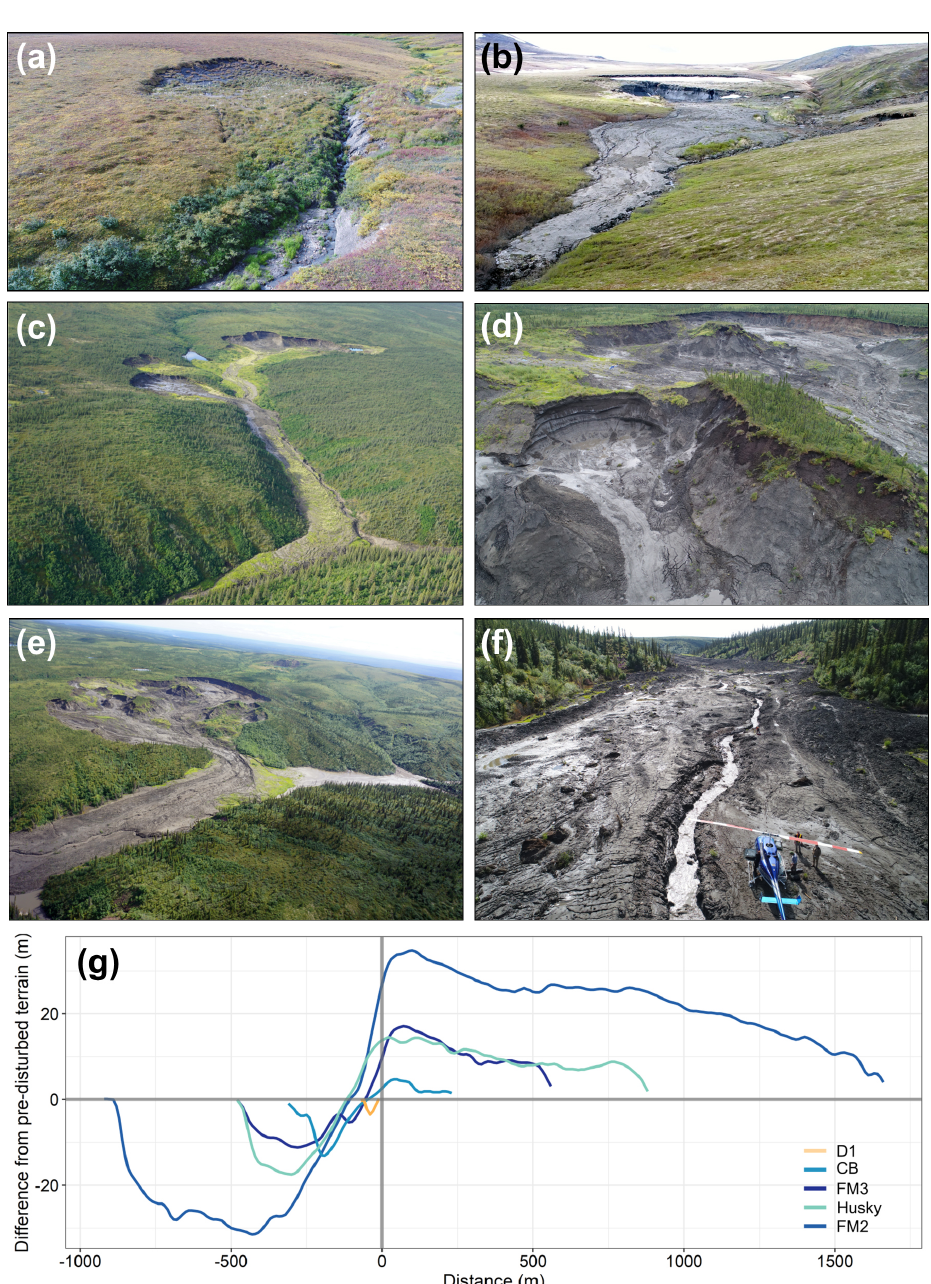
Figure 2. Examples of retrogressive thaw slumps and debris tongue deposits (a–f) as well as the elevation-normalized scar zone and debris tongue profiles for a size and age disturbance continuum on (g) Peel Plateau, Northwest Territories, Canada. (a) A small, shallow slope-side thaw slump (D1) with a vegetated lower slope and active headwall. (b) Oblique photograph of CB in June 2019 showing a debris tongue in the foreground, secondary slumps on the right side of the valley, a large polycyclic (secondary) headwall in the central scar zone, and a small upper (primary) headwall in the background. (c) Husky thaw slump scar and debris tongue, secondary slumps on the left, a small debris-dam lake, and a slump-drained lake and residual pond to the right of the upper slump. (d–f) FM2 mega slump and debris tongue. (d) FM2 headwall showing banded relict massive ice and relatively thaw-stable organic deposits and eroded glaciofluvial deposits in the upper right (background). (e) FM2 thaw slump scar area and chute where sediment enters the valley to form the debris tongue and a debris-dam lake. (f) The debris tongue surface and the stream channel, which has started to incise the deposit. (g) Elevation-normalized retrogressive thaw slump scar ( − values) and debris tongue ( + values) topographic profiles. Profiles are differenced from the pre-disturbed terrain surface. Scar zone transects are from the slump headwall to the intersection with the stream channel, and downstream transects extend to the end of the debris tongue. Retrogressive thaw slumps and transects are shown in Fig.